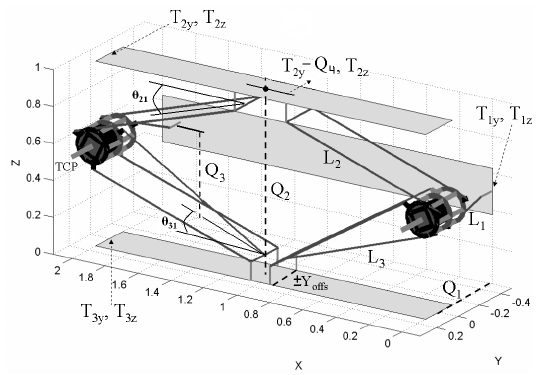
Figure 5: The 3-DOF reconfigurable Gantry-Tau robot.